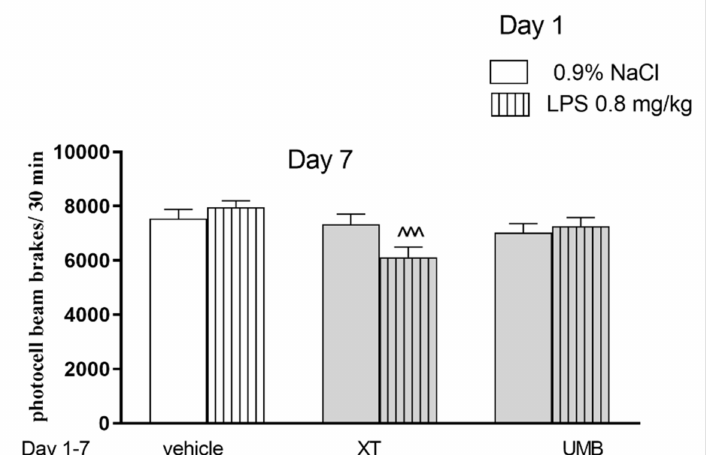
Figure 3. Effect of LPS (0.8 mg/kg, i.p.) and xanthotoxin (XT, 15 mg/kg) and umbelliferone (UMB, 15 mg/kg, i.p.) administered separately or in combination on spontaneous locomotor activity in mice. Mice were injected with XT and UMB 60 min after LPS administration and then consecu- tively for 6 days. On the seventh day immediately after coumarins injections mice were placed in actimeters. Locomotor activity (number of interruptions of light beams) was recorded for the 30 min. Data is presented as the means ± SEM. n = 9–10 ˆˆˆ p < 0.001, vs. saline-treated group; (post hoc Bonferroni’s